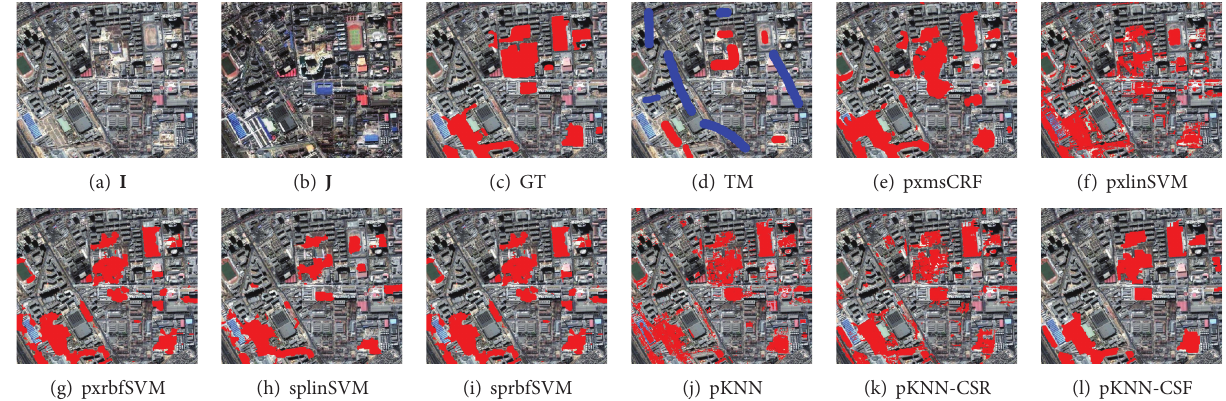
Figure 5: DS2 and and the resultant change maps (CMs) by different methods.